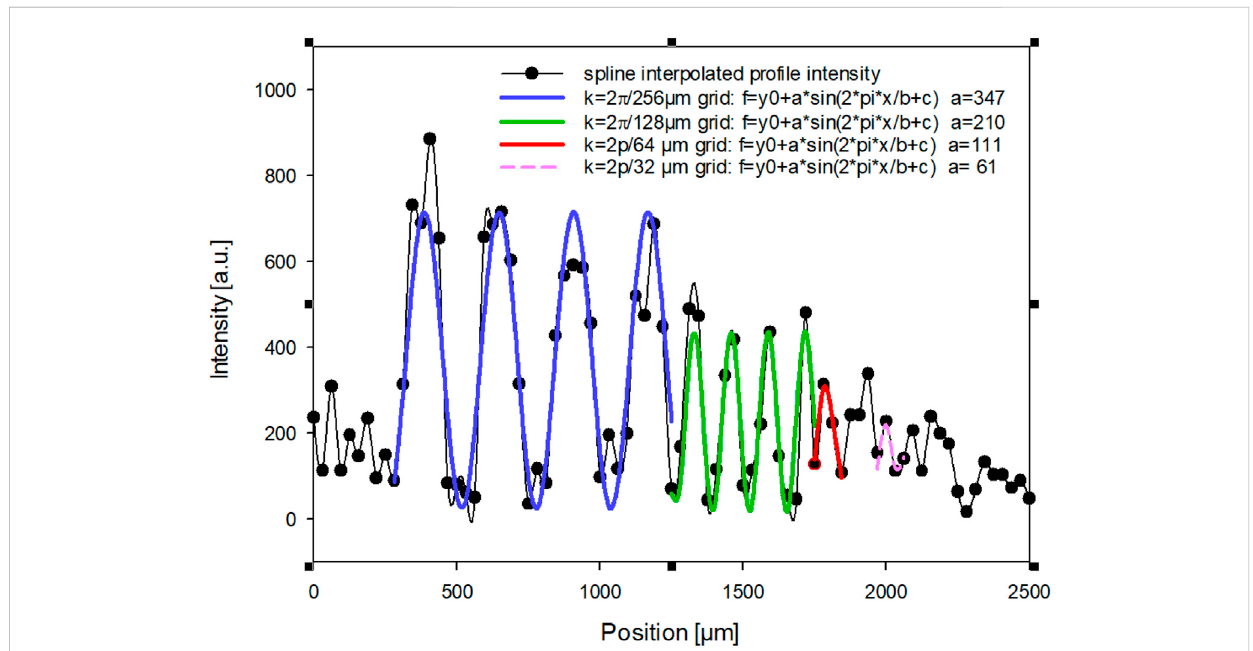
FIGURE 11 Intensity pro fi le along the path indicated in Figure 10 for evaluation of the relative modulation depth and the MTF. Evaluated regions for determination of maxima and minima are indicated by colour encoded lines ( fi t data for modulations with high SNR are plotted). The pro fi le line is only one pixel wide (31 µm) and features a modulation to noise ratio for the lowest spatial frequency (left) MNR (K=2 π /256 µm), (cid:1) 9.2.